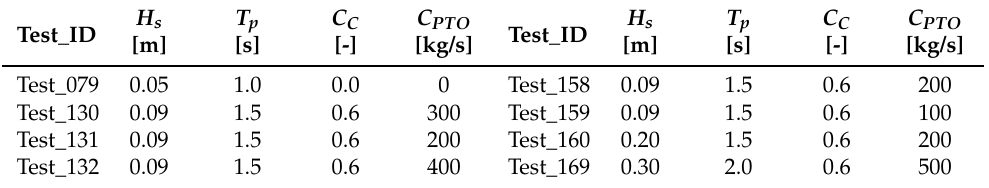
Table 9. Overview of the resistive control strategy tests for irregular waves.